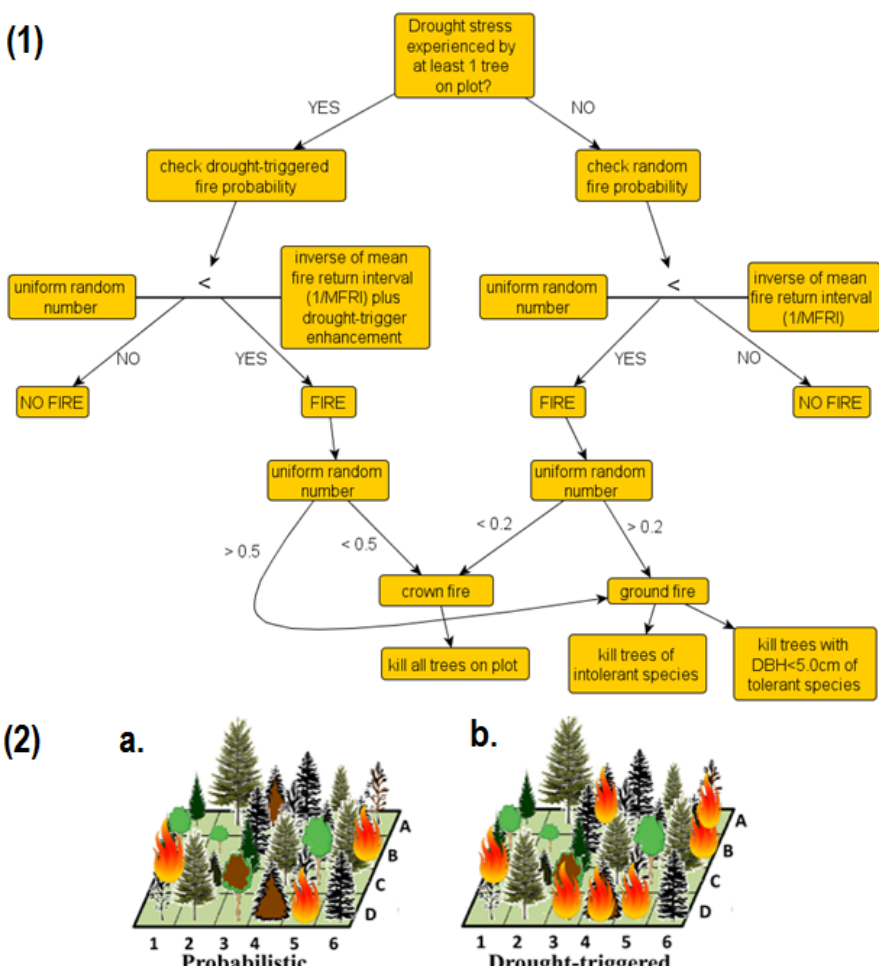
Figure 1. ( 1 ) Process flow for two DISTURB-F modes: based on mean annual probability and additionally based on a drought trigger fire killing all or only susceptible tree species in plots; ( 2 ) visualization of fire on a simulated grid of plots. ( a ): fires based on MFRI/probability on a simulated landscape; fire kills all or only susceptible tree species in plots B6, C1 and 5D; ( b ): fires based on probability and drought; results in mortality of all or only susceptible species, understory trees also burn, depending on fire intensity, as shown in drought-stressed plots A3, A6, D4 and D5, designated by brown trees here and on the left.